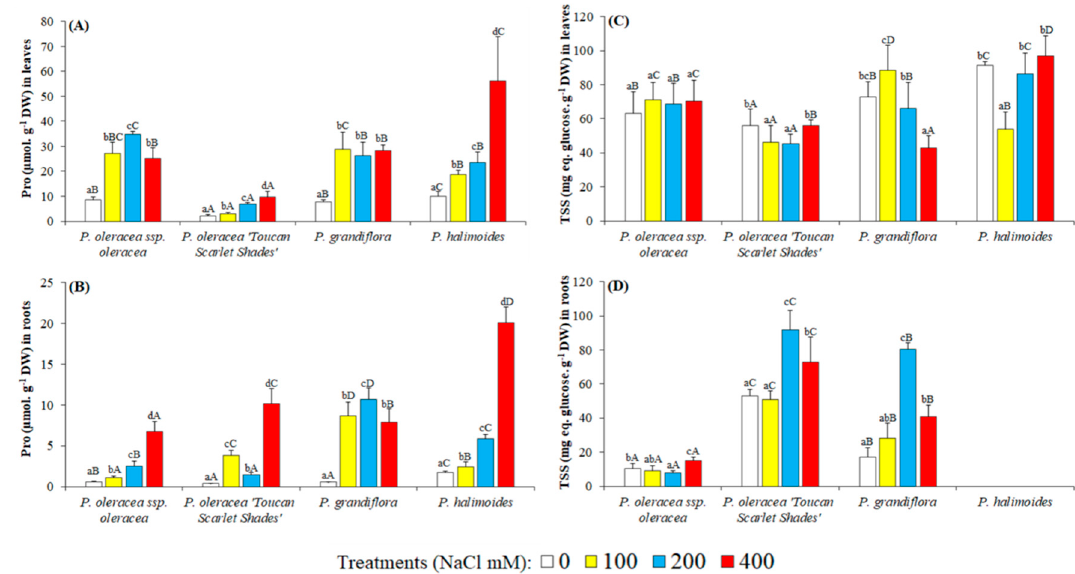
Figure 4. Osmolytes quantified in the four Portulaca genotypes subjected to salt stress treatments. Proline (Pro) and total soluble sugars (TSS) accumulation in the leaves ( A , C , respectively) and roots ( B , D , respectively). The values shown are means ± SE ( n = 5). Different lowercase letters above the bars indicate significant differences between the control plants, and different capital letters indicate significant differences between different genotypes.